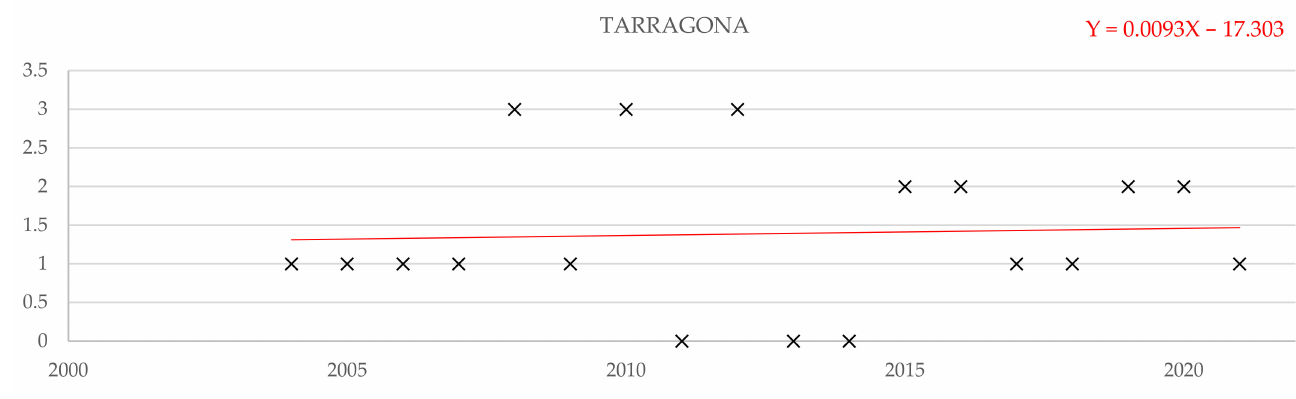
Figure 31. Number of times Tp has exceeded the expected Tp in 100 years in